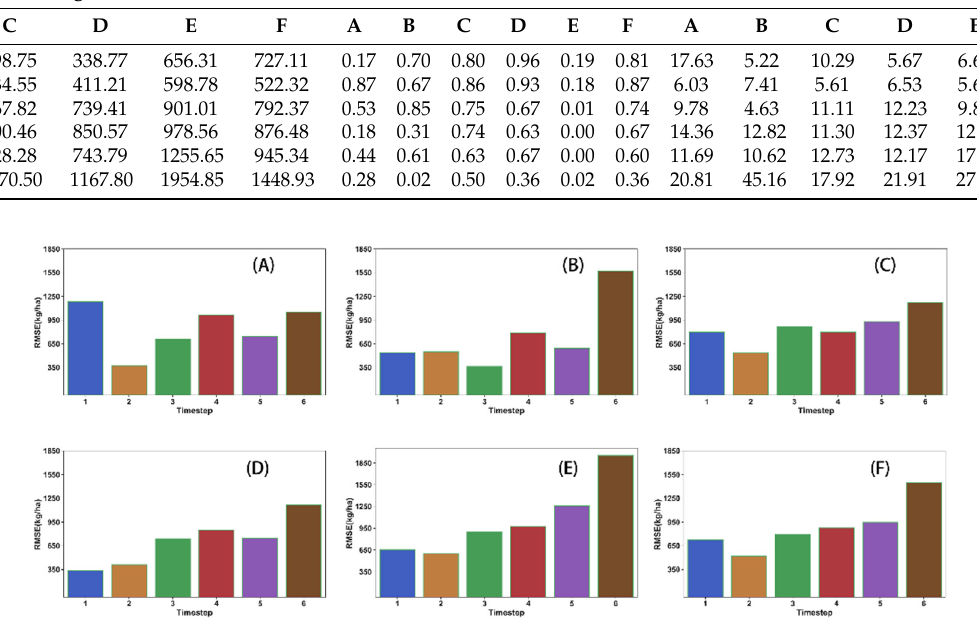
Figure 8. The model performance (predicted RMSE) using different time steps for only one period of the growing season. ( A ) one time step; ( B ) two time steps; ( C ) three time steps; ( D ) four time steps; ( E ) five time steps; and ( F ) six time